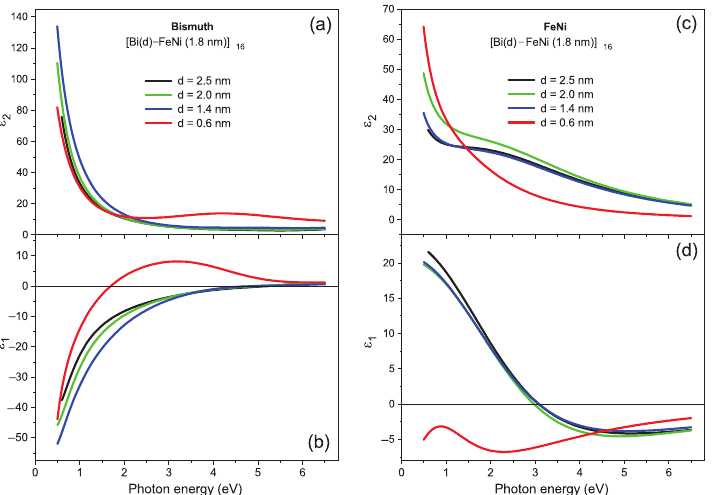
Figure 4. The complex (pseudo)dielectric function spectra, ε 2 ( ω ) and ε 1 ( ω ) , of the ( a , b ) Bi layers and ( c , d ) FeNi layers in the [Bi( d )–FeNi(1.8nm)] 16 structures shown for the Bi layer nominal thickness values d = 0.6, 1.4, 2.0, and 2.5nm by solid red, blue, green, and black curves, respectively.